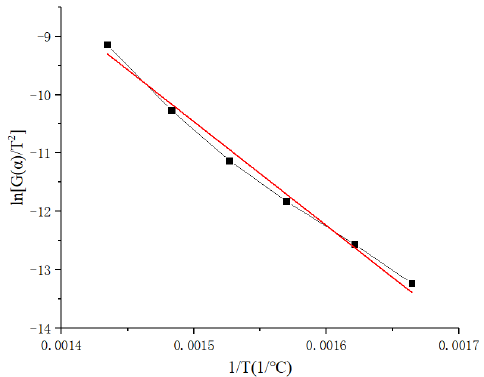
Figure 7. Linear fitting results based on the Coast–Redfern method.